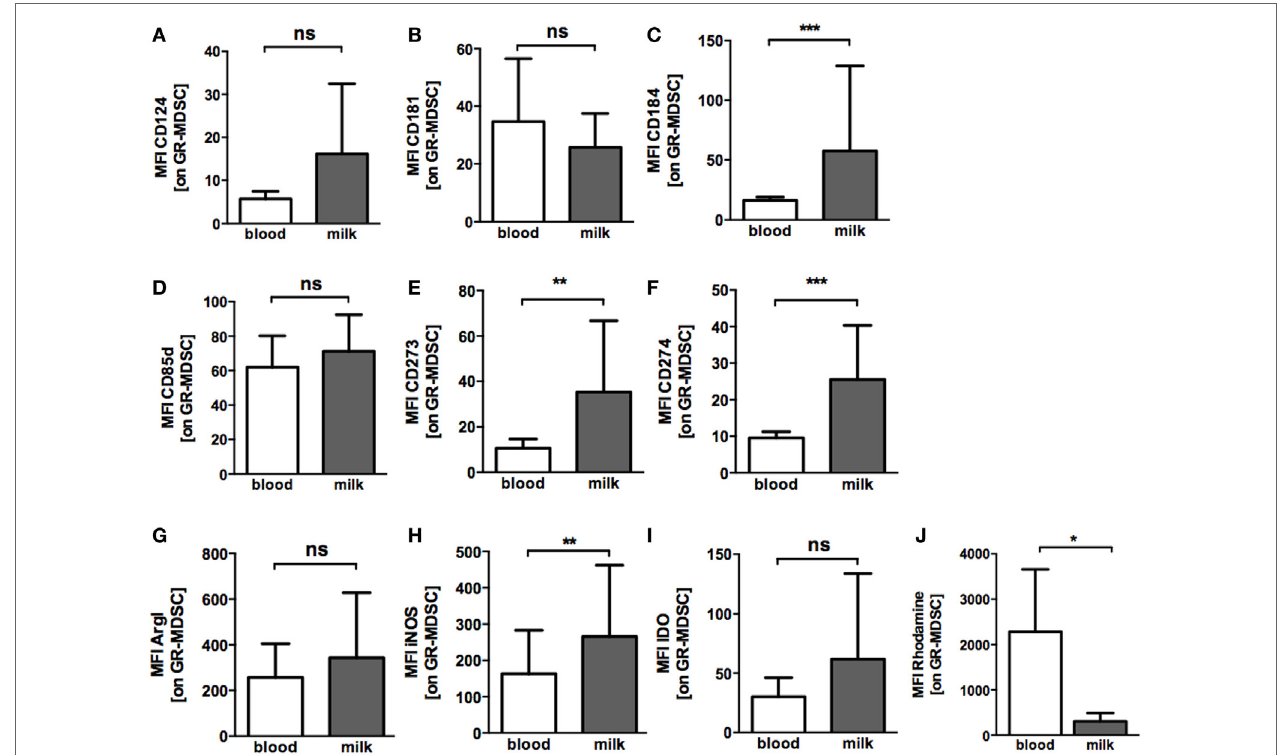
FigUre 3 | Expression of chemokine receptors, co-inhibitory molecules and effector enzymes on granulocytic MDSC (GR-MDSC) from BM. Mononuclear cells were isolated from peripheral blood of breastfeeding women and milk cells isolated from BM of the same person and analyzed by flow cytometry. Intracellular staining for arginase I (ArgI), iNOS, and IDO was performed and reactive oxygen species (ROS)-production detected by dihydrorhodamine. (a–J) Bar graphs show the MFI for receptor and enzyme expression on GR-MDSC in peripheral blood (blood, white bars) and BM (milk, gray bars). Bars represent data from 5 to 10 independent experiments and mean and SD are indicated. * p < 0.05; ** p < 0.01; *** p < 0.005; ns, not significant; Wilcoxon matched-pairs signed rank test or paired t